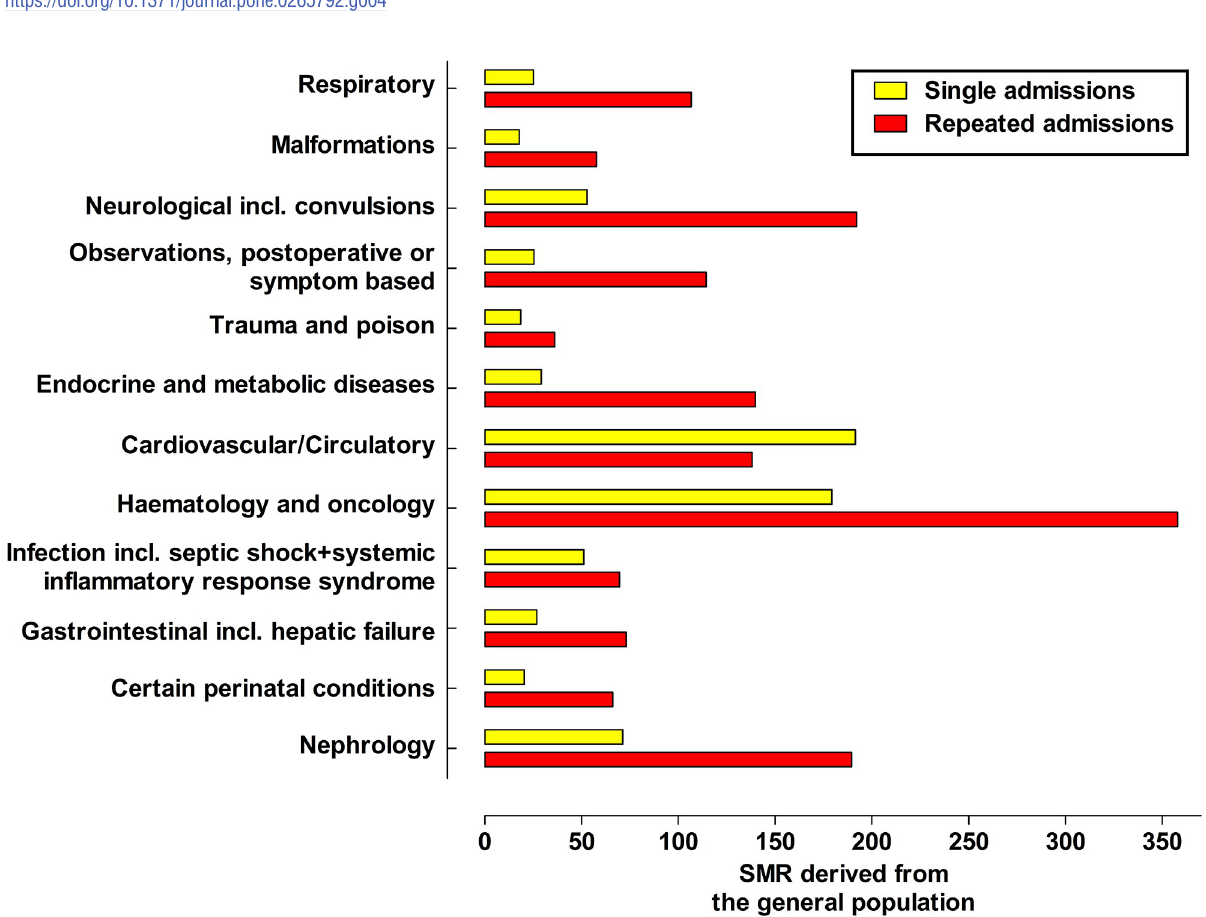
Fig 5. Bar graph showing SMR for different PICU admission diagnosis. The presented data are from the first admission to the PICU. The SMRs are derived from the general population.